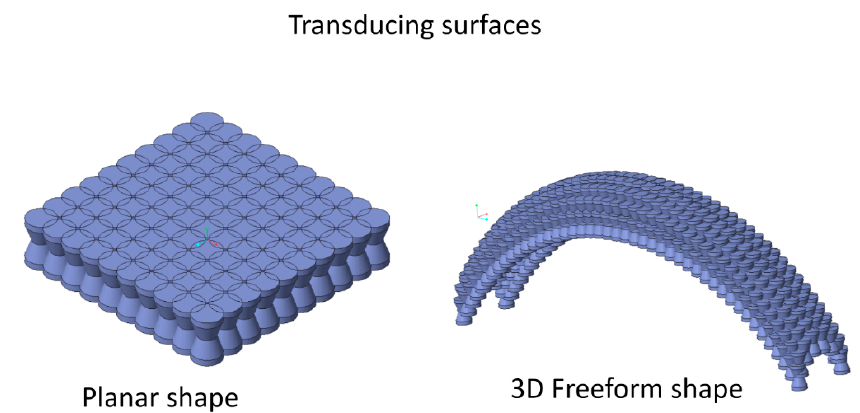
Figure 3. Possible parallel arrangements for extended transducing surfaces.